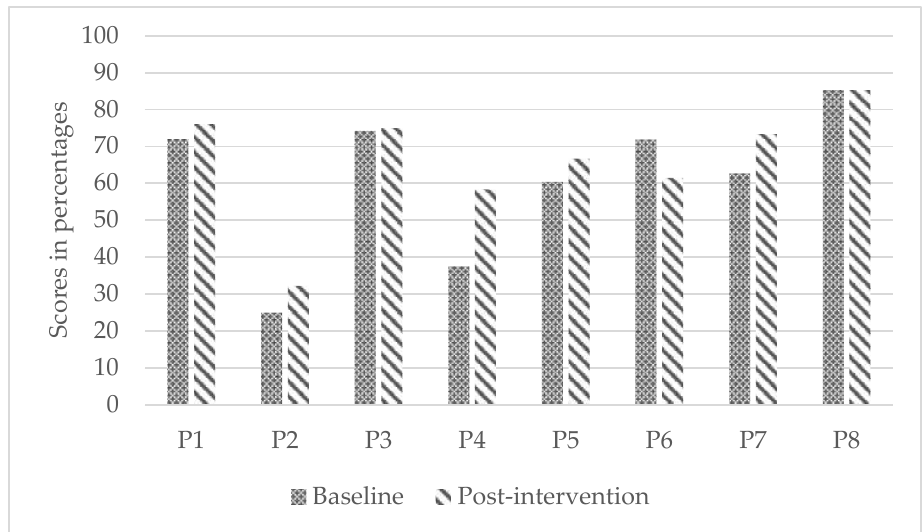
Figure 3. Individual improvements in parent-perceived wheelchair skills capacity from baseline to post-intervention.